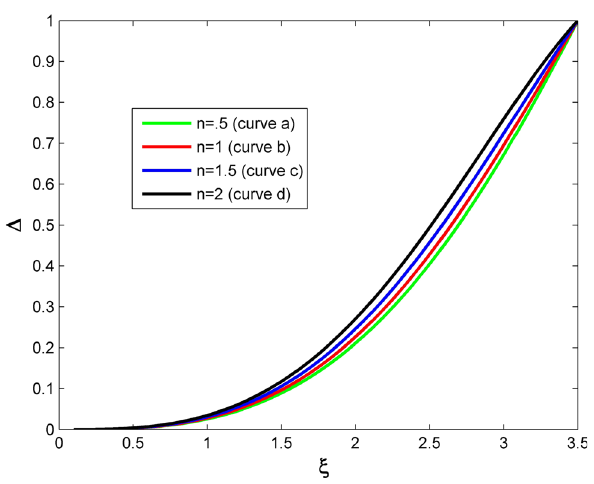
Fig. 6 Graphs between ξ and (cid:7)